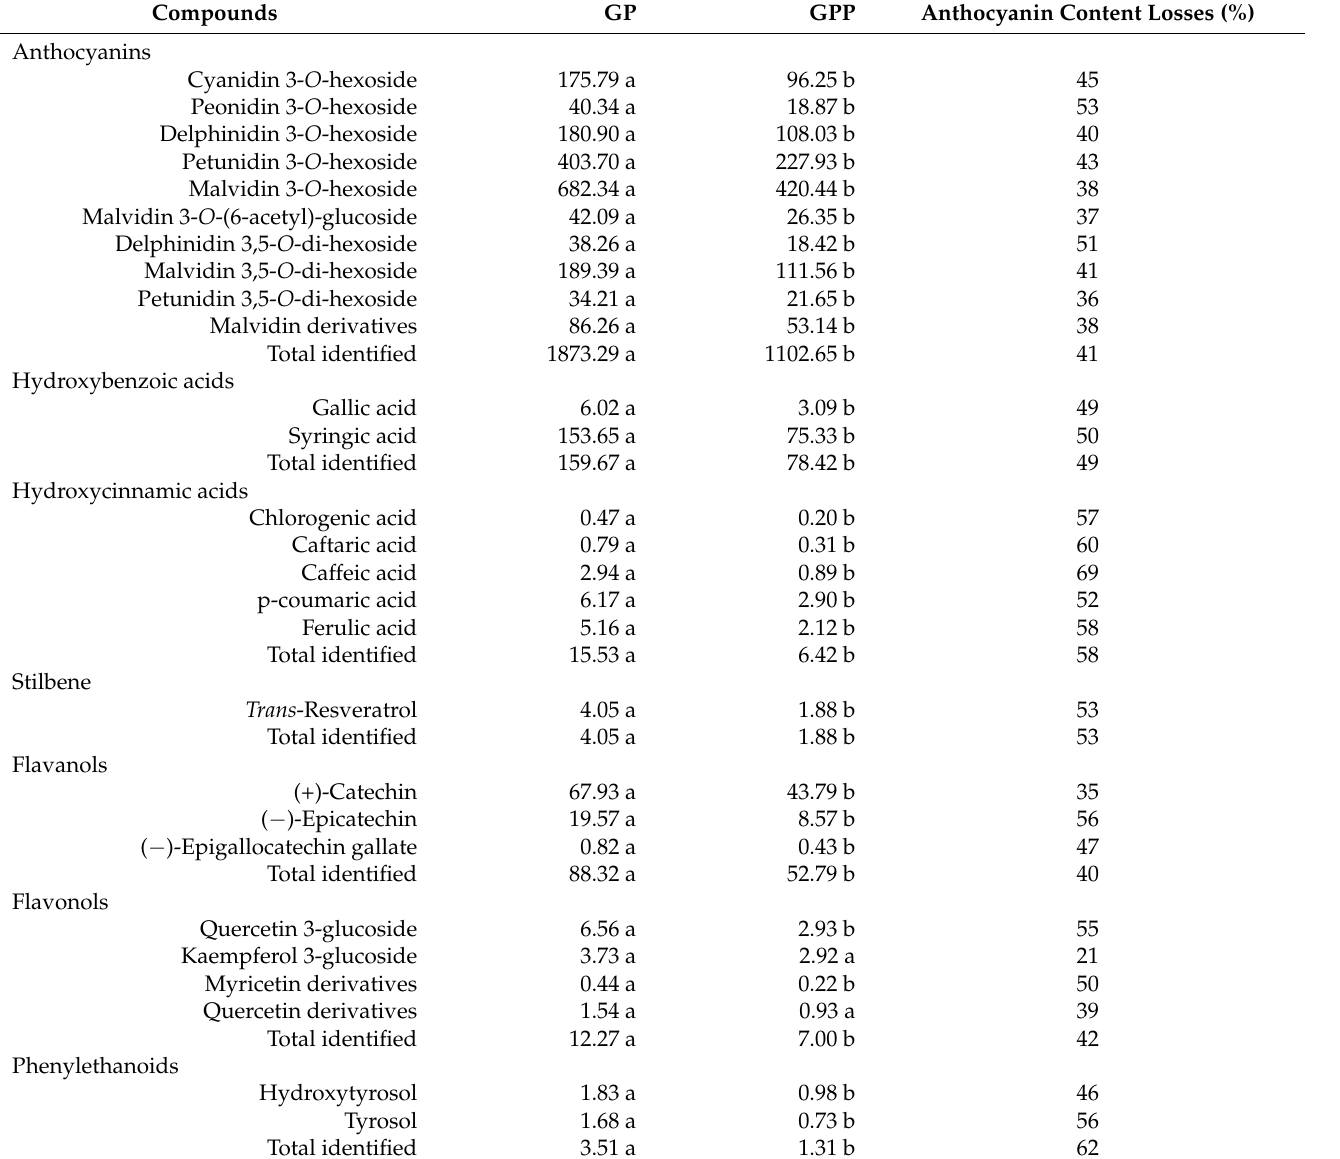
Table 2. Phenolic compound content (mg 100 g − 1 DW) identified in grape pomace and grape pomace powder (GPP) from Tintorera grapes.